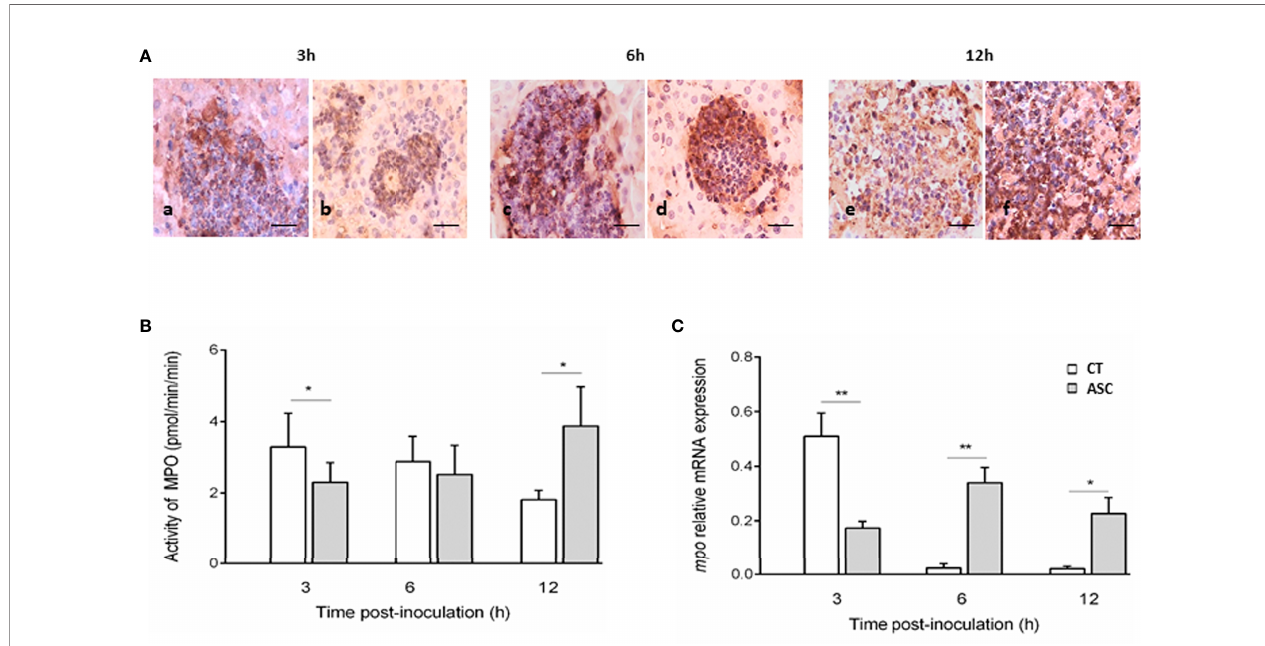
FIGURE 2 | Immunohistochemistry of MPO in in fl ammatory in fi ltrates (A) . The in fl ammatory cells present in the lesions of the CT (Aa, Ac, Ae) and ASC (Ab, Ad, Af) animals showed a positive reaction to MPO at the three times studied. Bar = 40 m m. At 3 h, MPO activity was lower in the ASC group than that in the CT group; at 6 h, the activity was similar in both groups, and at 12 h, MPO activity was greater in the ASC group than that in the CT group (B) . (C) mpo expression was signi fi cantly increased in hamsters treated with ASC compared with the CT group at 6 and 12 h or decreased at 3 h p.i. **p < 0.01, *p <